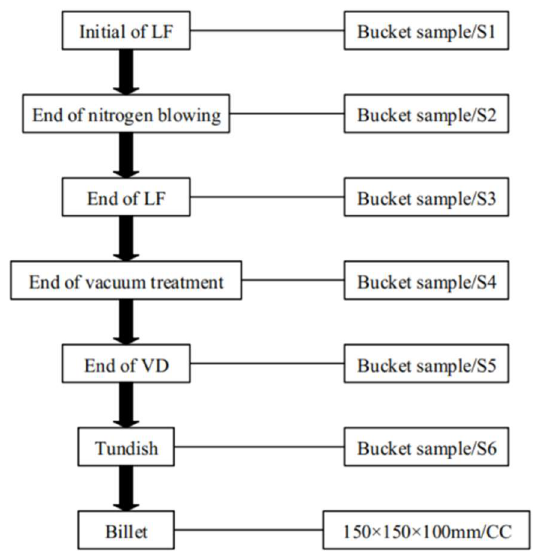
Figure 2. The number of samples.